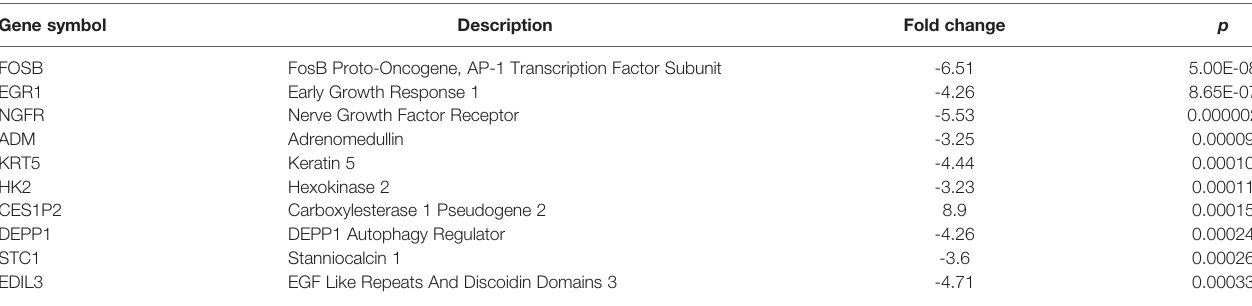
TABLE 3 | Genes differentially expressed between shRNA- MGRN1 group and shNC group. Gene